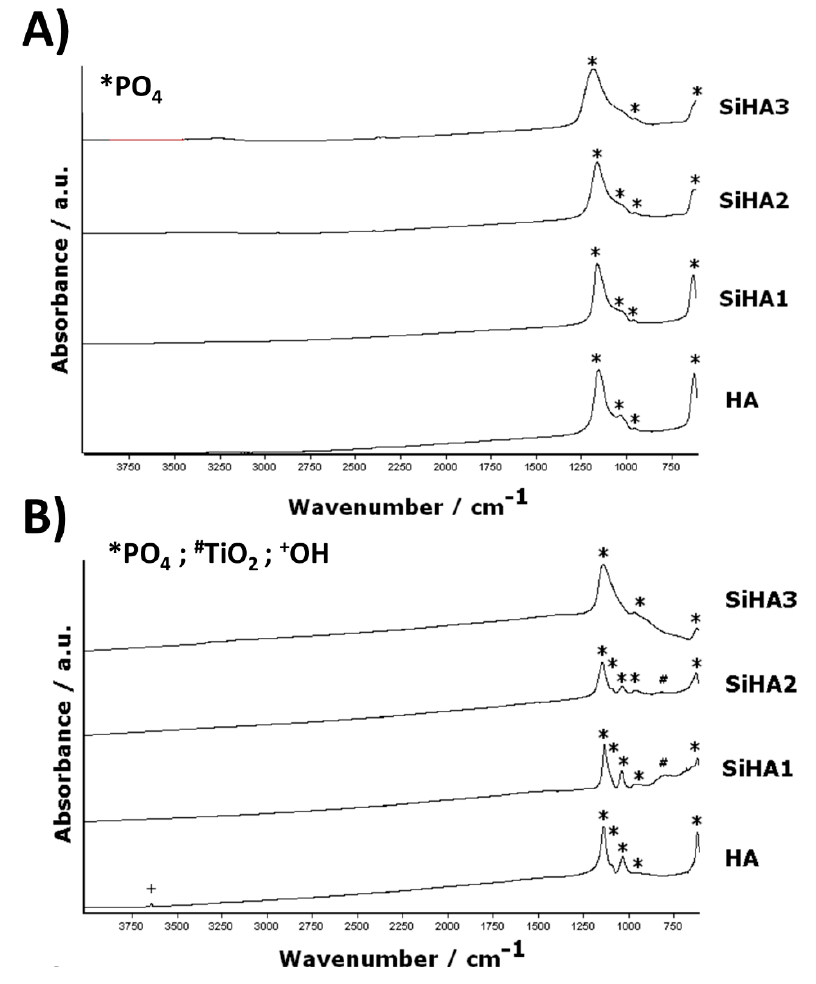
Figure 7. FTIR Spectra of ( A ) as deposited HA and SiHA thin films on CPTi substrates and ( B ) HA and SiHA thin films on CPTi substrates heat treated at 600 °C for 2 h in argon.